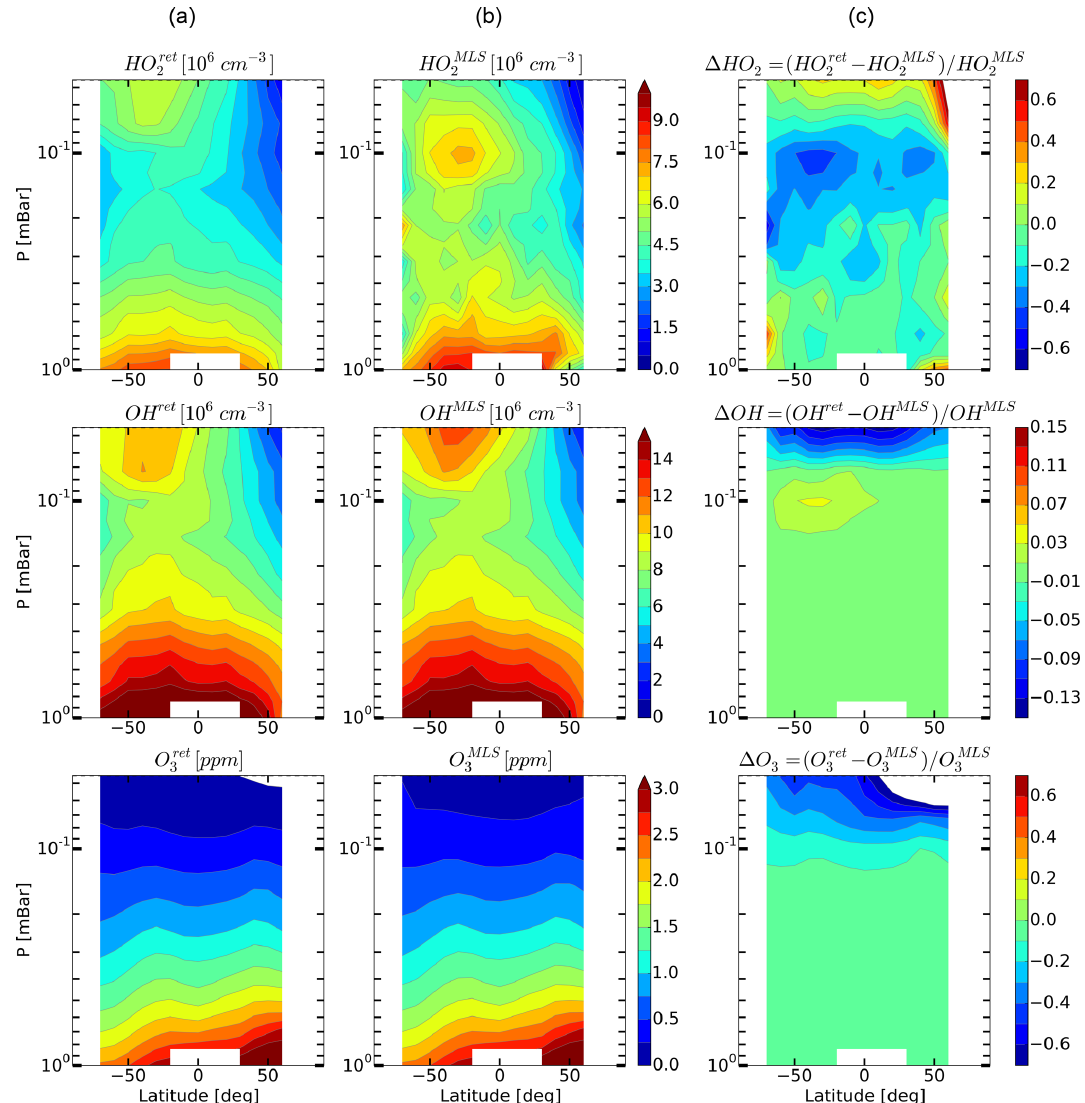
Figure 6. Daytime monthly averaged zonal mean retrieved (a) and measured (b) distributions of HO 2 , OH, and O 3 and their relative difference (c) in January